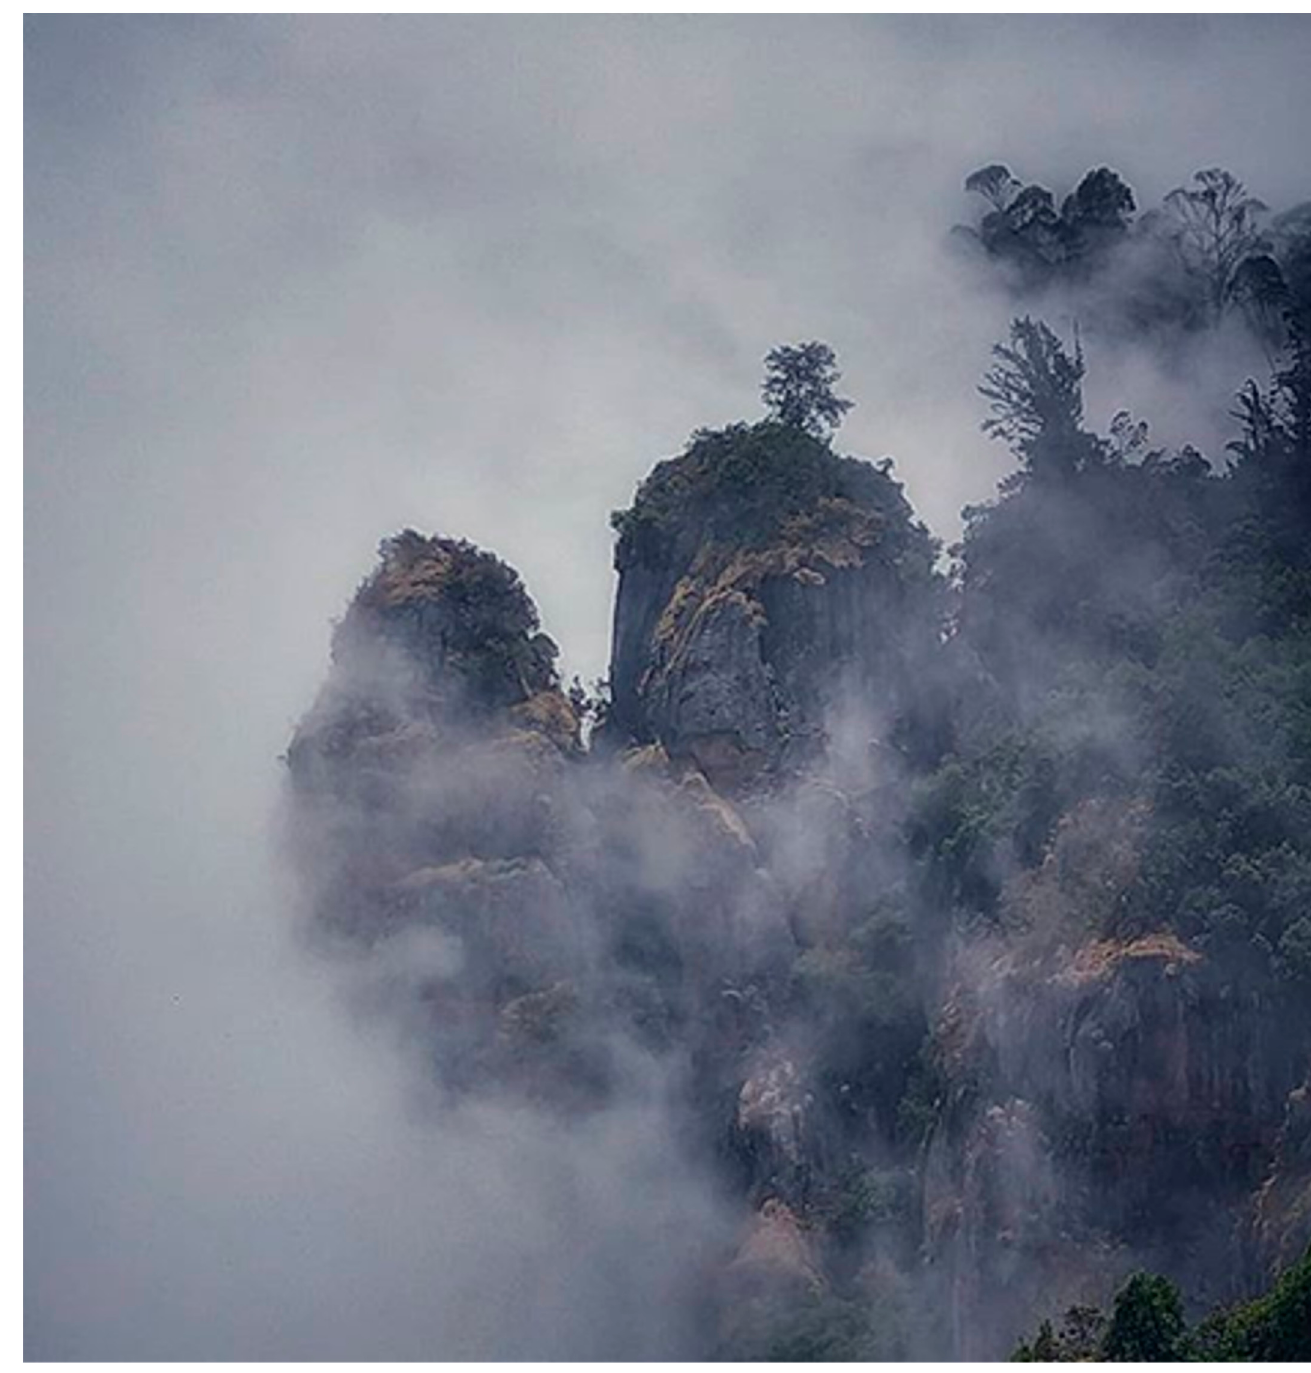
Figure 2. The mist envelops the island (1976). https://twitter.com/login/error?username_or_email=melin2000&redirect_after_login=%2Fhashtag%2Fkingkongmovie (accessed on 1 January 2021).